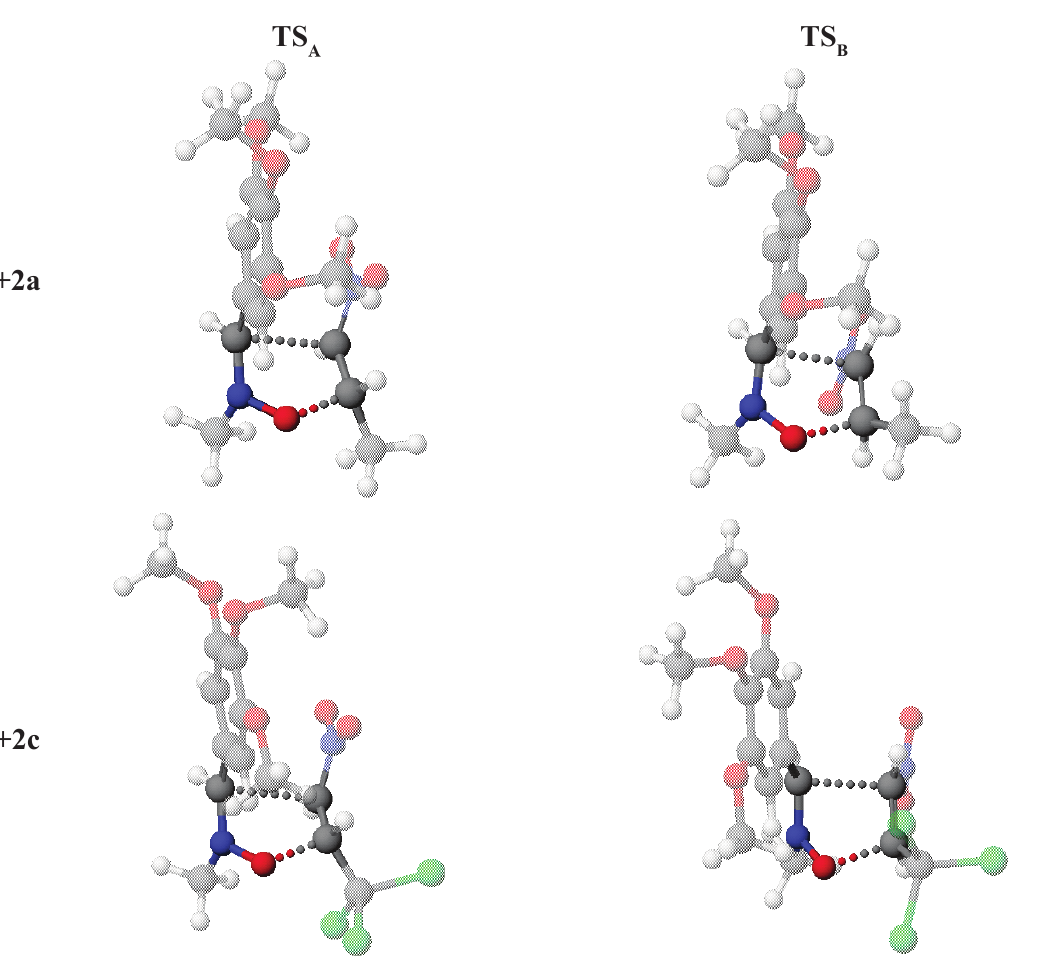
Figure 2. Transition complexes geometries for 1+2a and 1+2c [2+3] cycloaddition